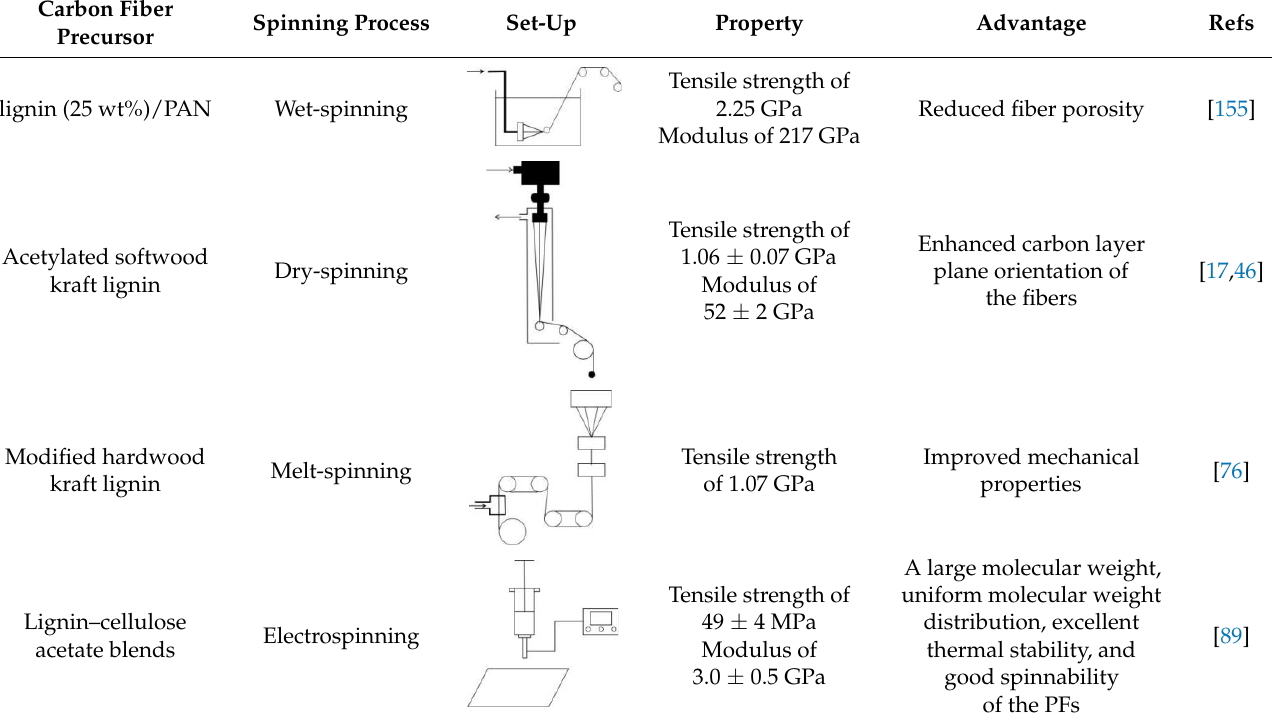
Table 3. Different spinning processes for producing lignocellulosic biomass-based CFs.